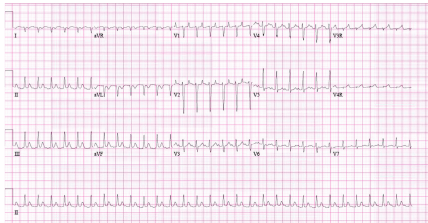
Figure 1: ECG showing narrow complex tachycardia with a long RP